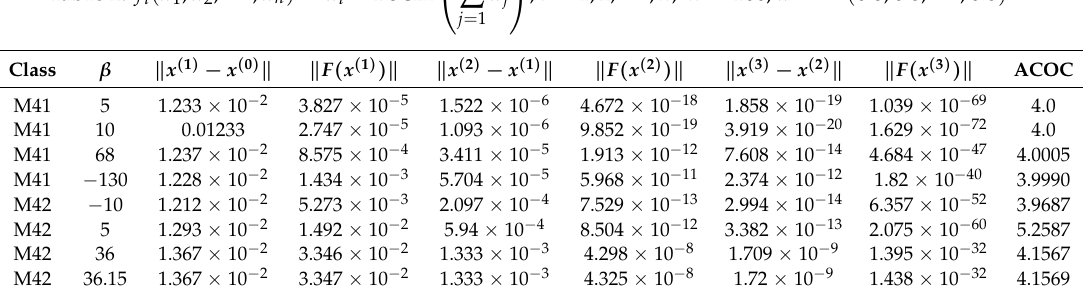
Table 2. f i ( x 1 , x 2 , . . . , x n ) = x i − 1.5sin